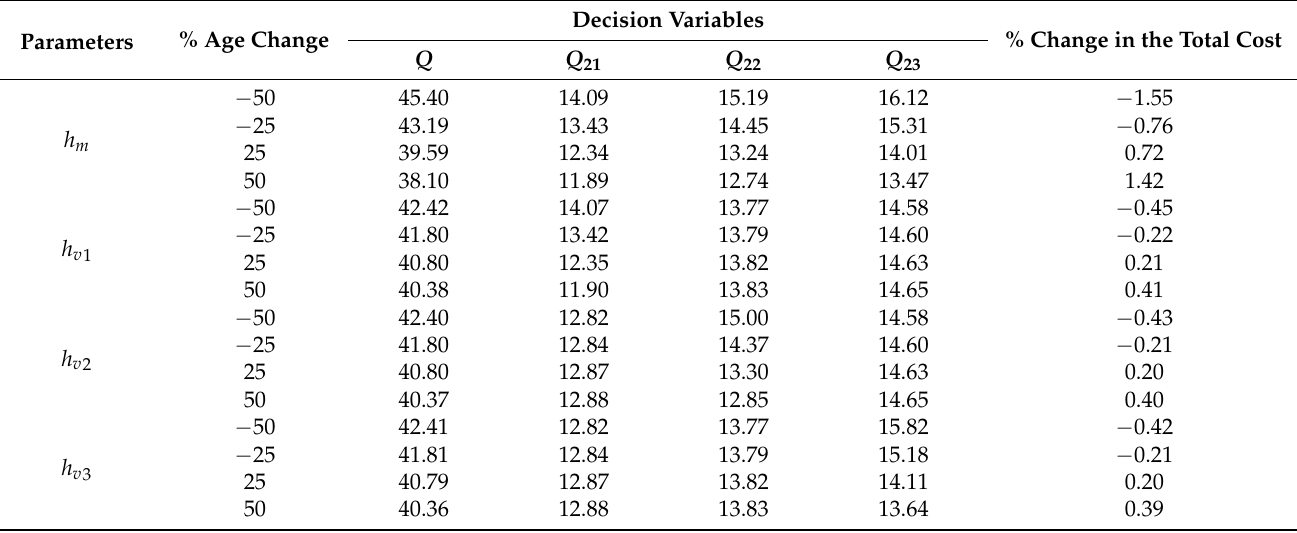
Table A2. Sensitivity analysis for holding cost of manufacturer and outsourcers.